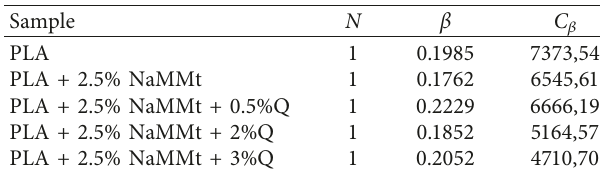
Table 1: Fitting parameters for the power laws expansion in equaiton (10).